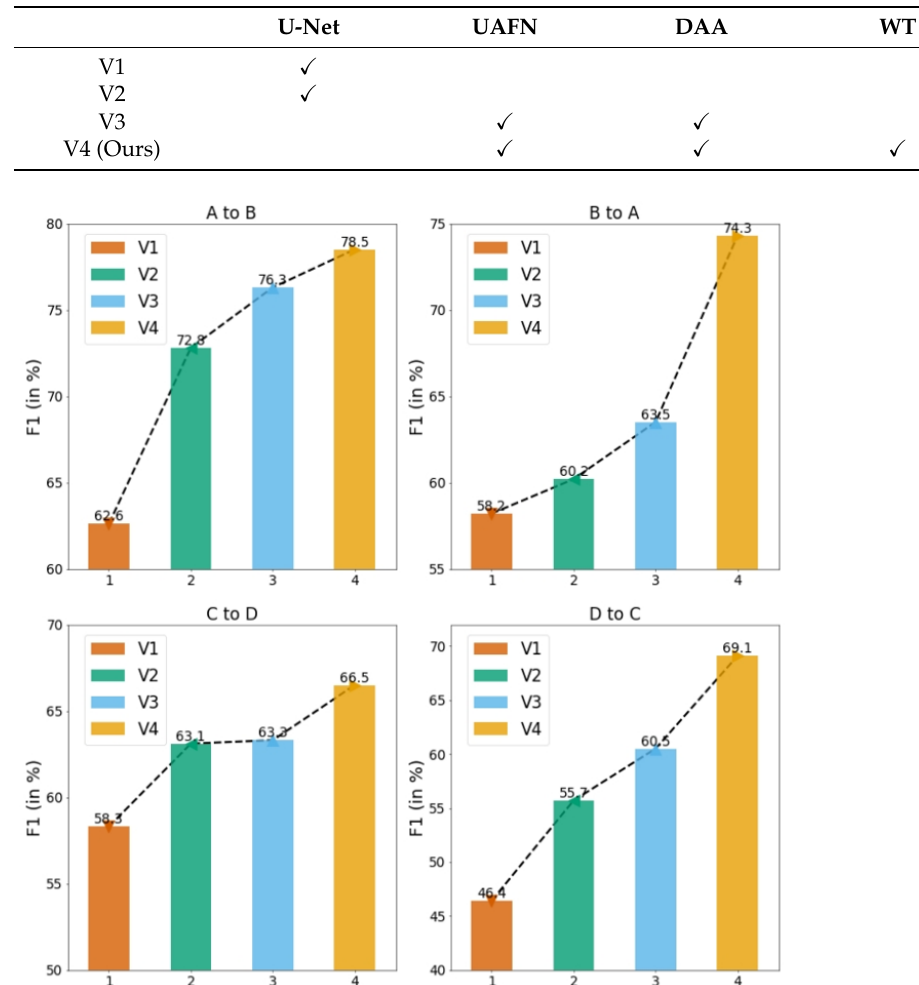
Figure 8. Ablation of experimental